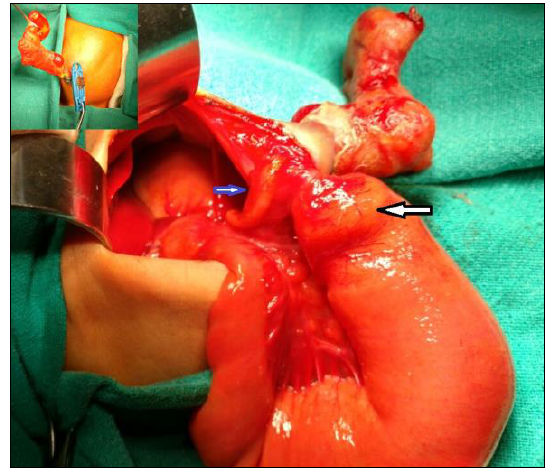
Figure 1: Showing dilated jejunum with atresia (big arrow) and distal transverse colon atresia (small arrow). Inset shows matted bowel mass exiting from a tiny hole in the muscle just right to the umbilical cord. Incidence of closed/closing gastroschisis is 6% of all gastroschisis.[1] There are various possible phenotypic presentation of closing gastroschisis, at one extreme end, there is closed abdominal ring with viable viscera; at other extreme it would be intestinal atresia at abdominal ring or infarction of midgut, intestinal resorption (matted thick fibrotic) and normal appearing abdominal wall termed as vanishing